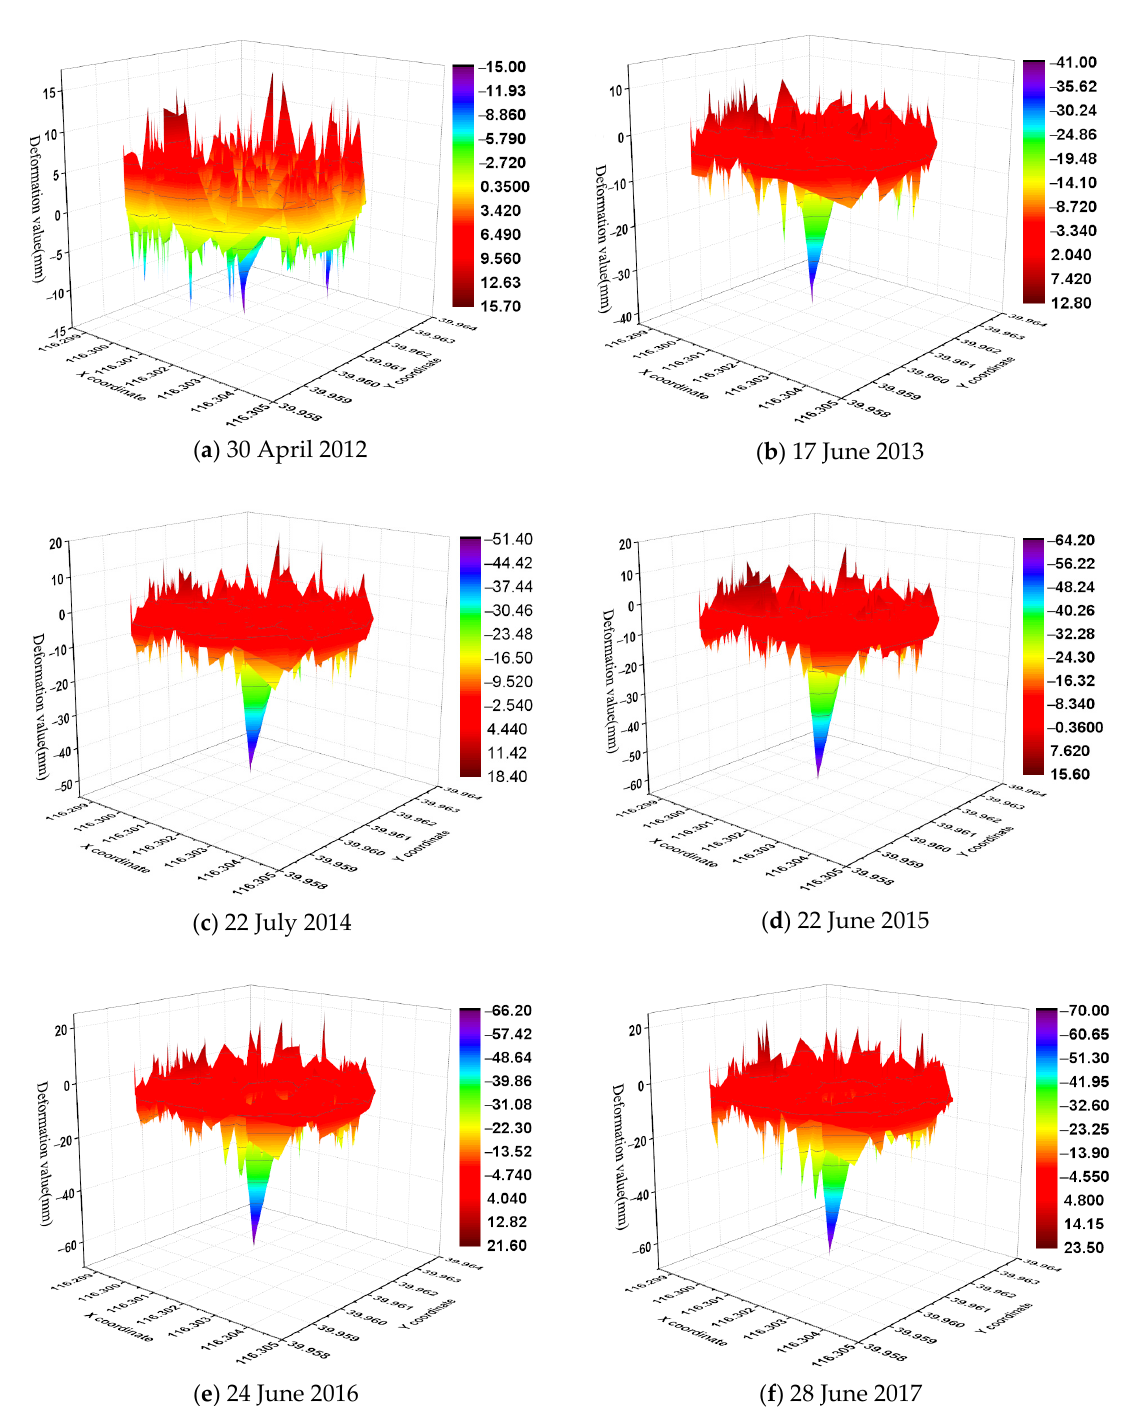
Figure 11. ( a – f ) 3D deformation models using Green’s function-based interpolation method. It can be seen from Figure 12 that the PS points of five piers have been declining slowly from 2013 to the beginning of 2017. The maximum deformation values all occurred on 2 August 2017. During the period from 1 July to 2 August 2017, the bridge deformation rate was the largest, as indicated by red lines in Figure 12. By the end of 2017, the maximum annual average deformation rate of PS points on pier D 4 was − 14.5